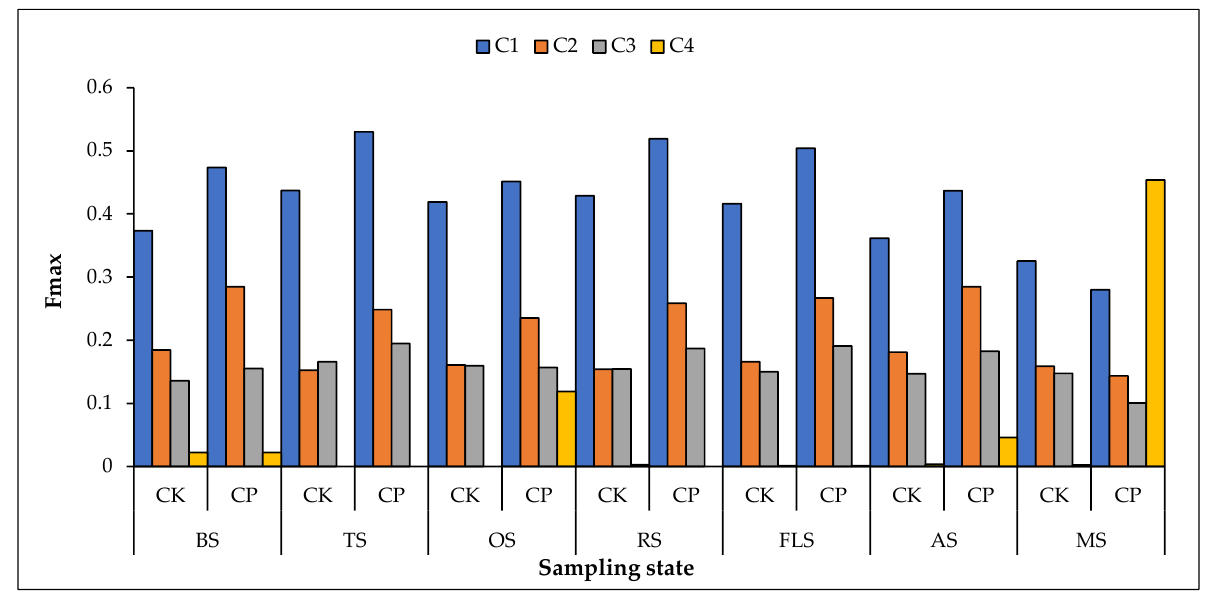
Figure 3. The change in F max for soil DOM fluorescence components obtained by PARAFACF max is the maximum fluorescence intensity. CK, no fertilizer application. CP, applying organic fertilizer. BS, before sowing. TS, at the tillering stage. OS, overwintering stage. RS, rising stage. FLS, flag leaf stage. AS, anthesis stage. MS, maturity stage. C1, UV and UVA humic-like. C2, tryptophan-like and UVA humic-like. C3, Exogenous and visible humic-like. C4, tyrosine-like. Fmax, the maximum fluorescence intensity (arbitrary unit, a.u.).